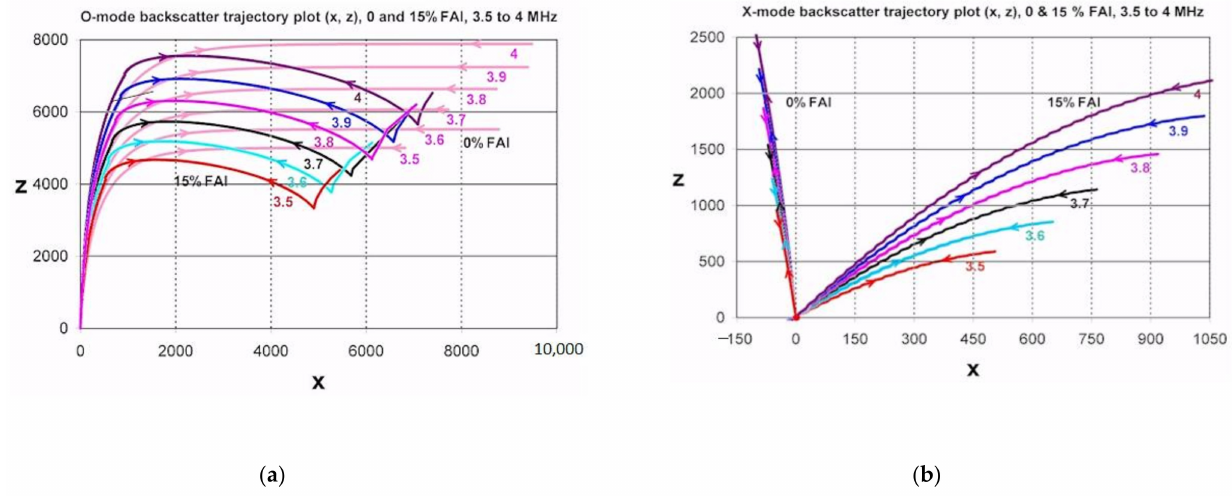
Figure 10. ( a ) Trajectories of backscatter rays of 3.5 to 4 MHz in the absence of FAI and in the presence of 15% FAIs, ( a ) o-mode rays and ( b ) x-mode